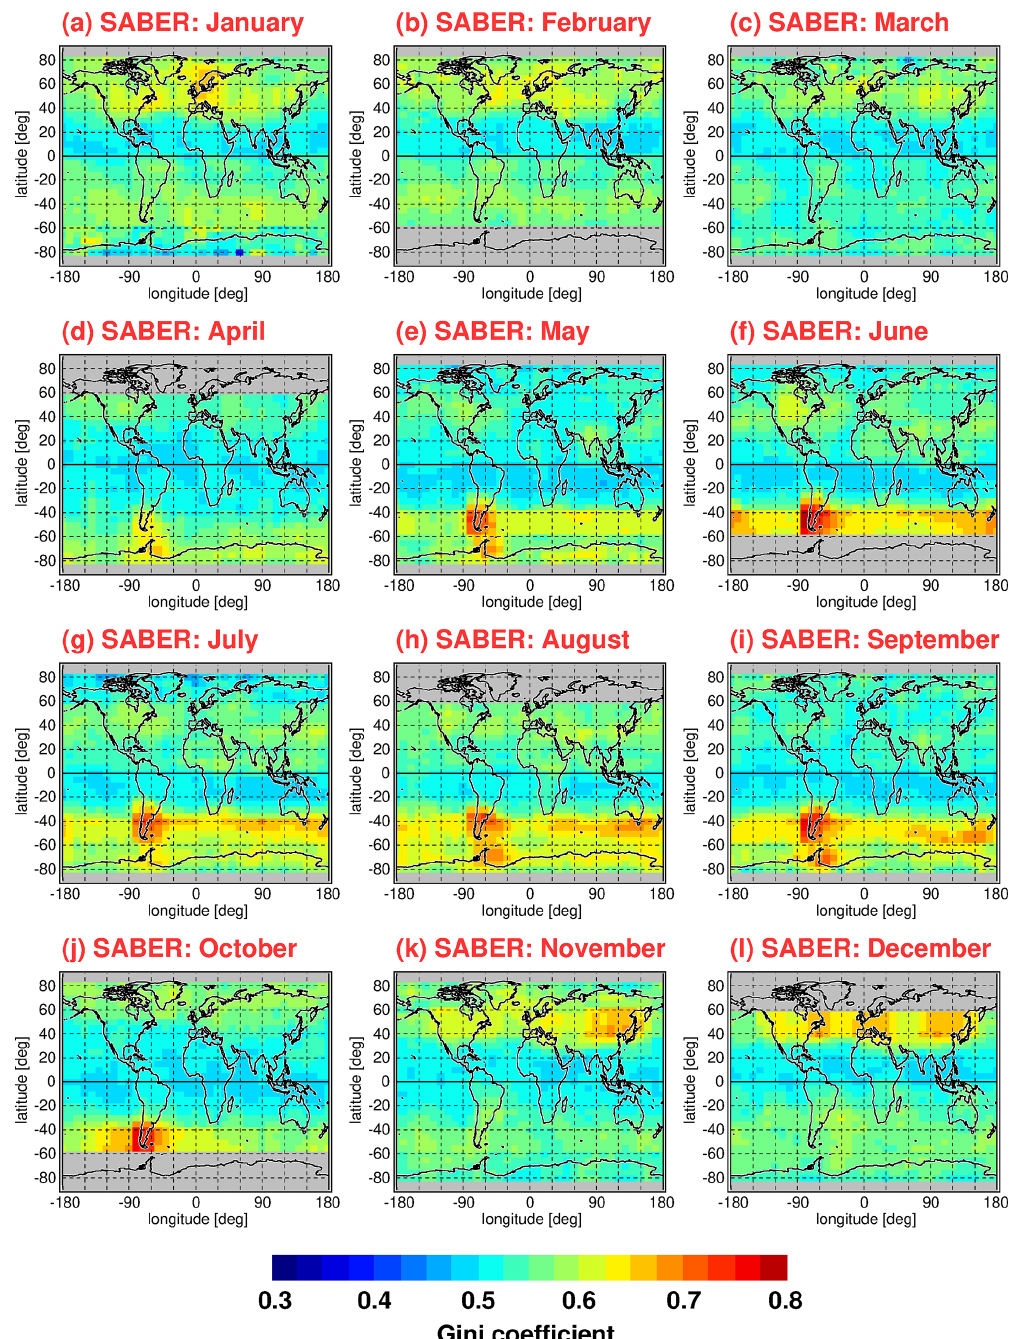
Figure A1. Same as Fig. 14, in that the Gini coefficients for SABER gravity wave absolute momentum fluxes for each multiyear mean calendar month are shown using a relatively large bin size of 20 ◦ × 30 ◦ (latitude × longitude), but without normalization of gravity wave momentum fluxes before calculating the Gini